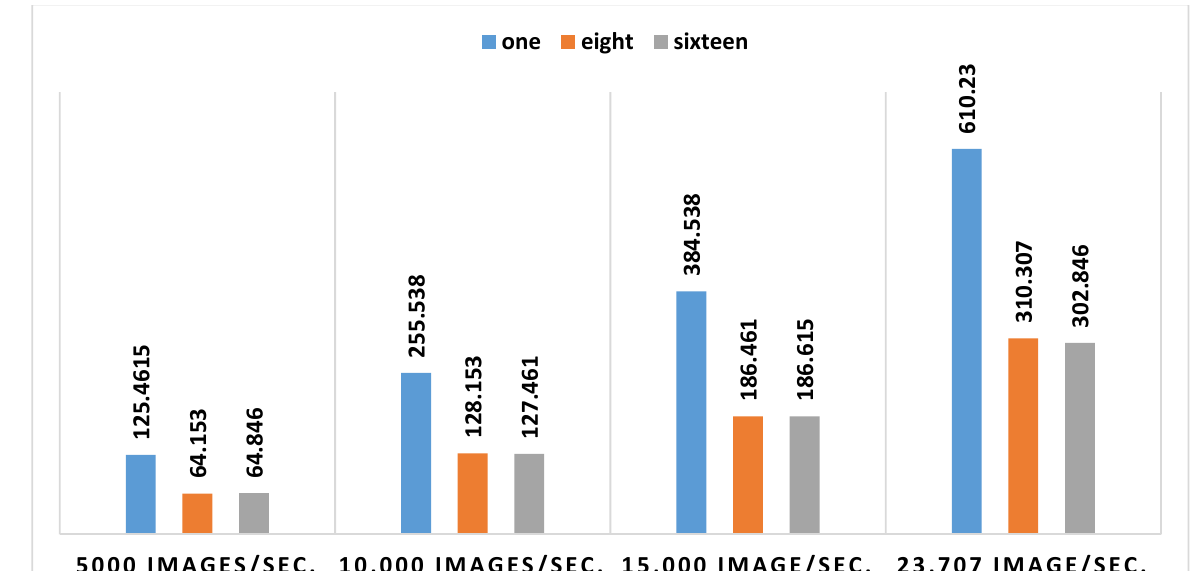
Figure 7. Average indexing time performance.